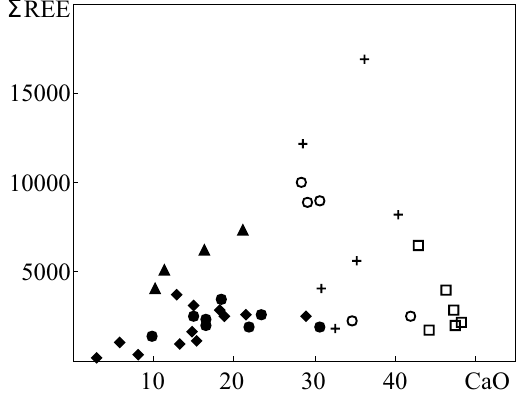
Fig. 11 – Composition of carbonatites and mica-rich rocks from Araxá plotted on the diagram (cid:1) REE vs. CaO. Symbols as in Fig.